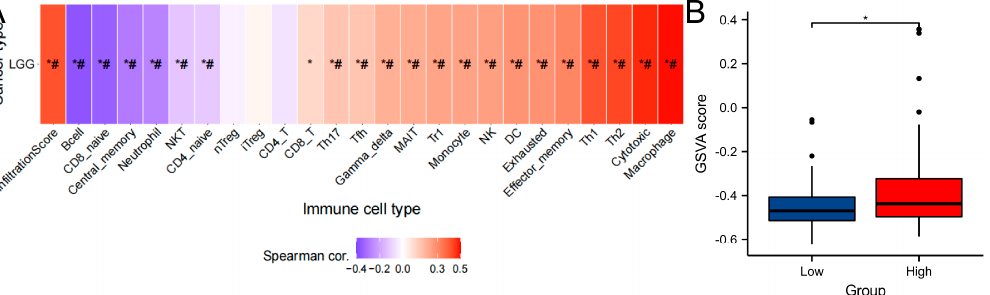
Figure 5. Immune cell infiltration analysis. ( A ) Correlation of immune infiltration based on the GSVA score. ( B ) GSVA scores were compared between groups. *: p value < 0.05; #: FDR < 0.05.